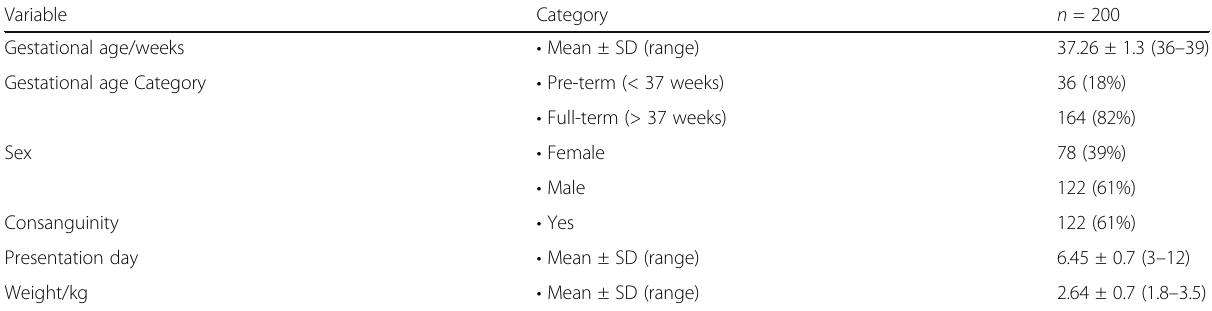
Table 1 Socio-demographic characteristics of the studied cases